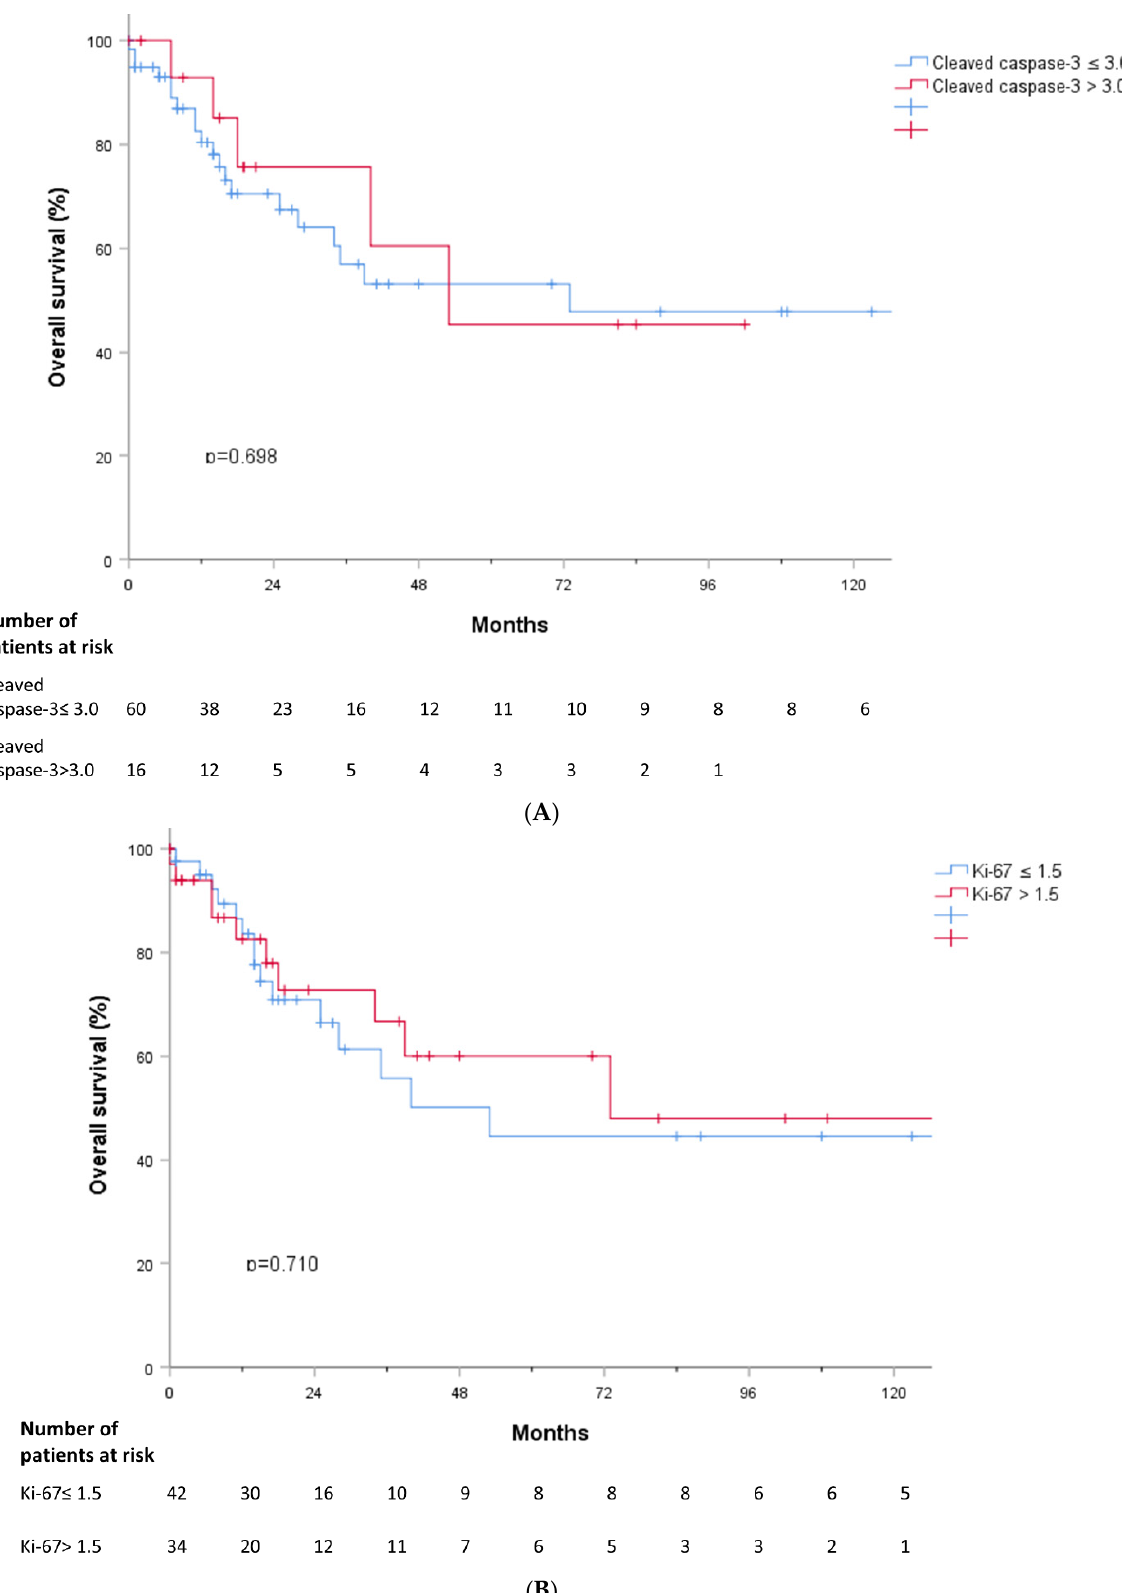
Figure 7. ( A ) Overall survival according to cleaved caspase-3. ( B ) Overall survival according to Ki-67.